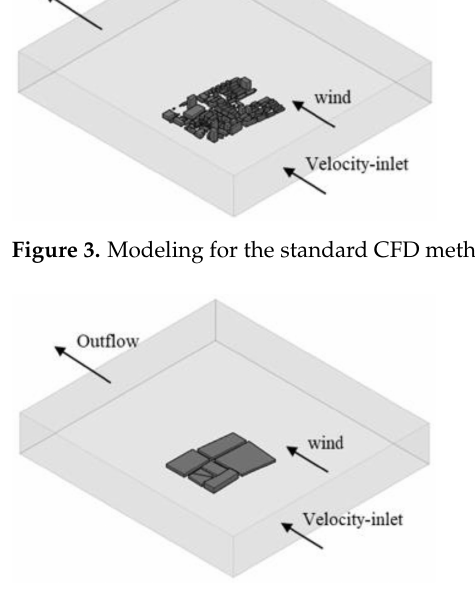
Figure 4. Method for modeling porous